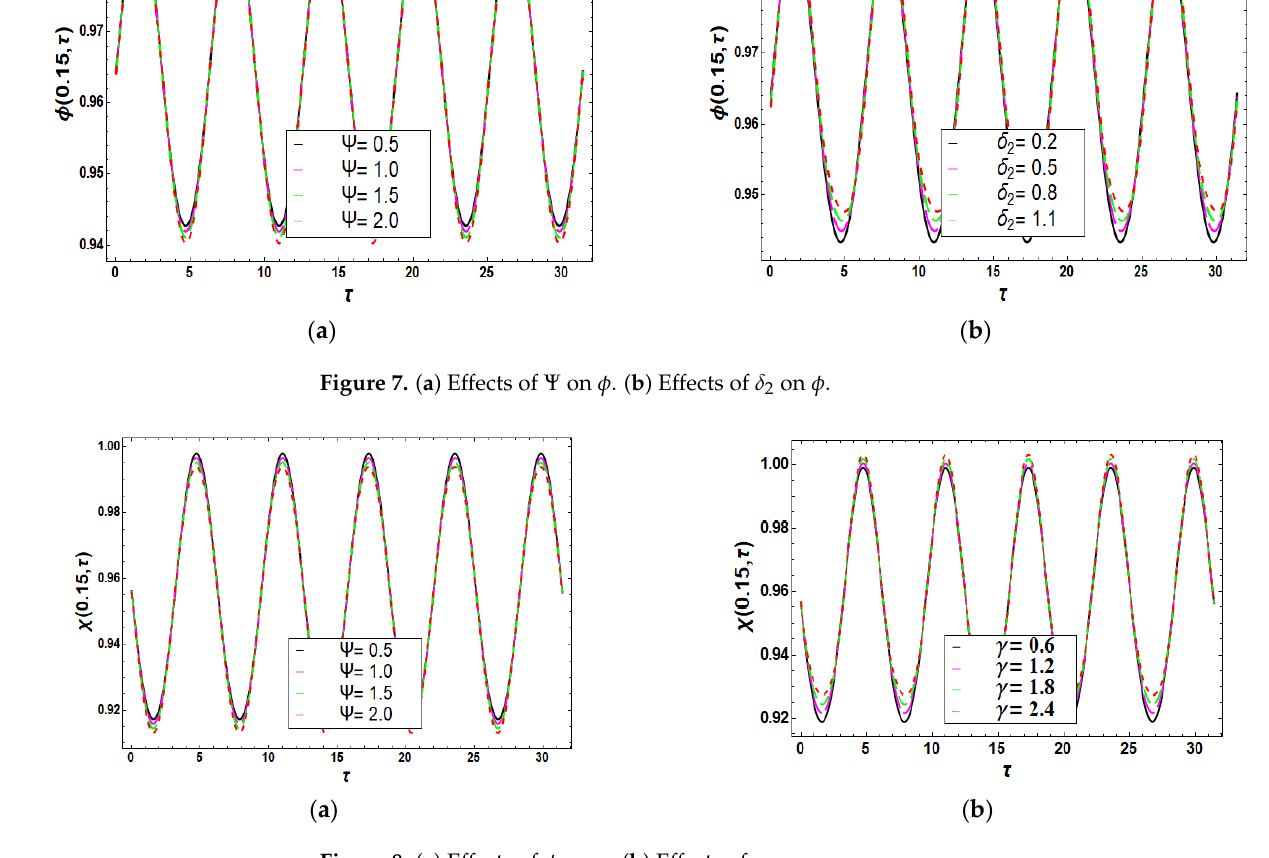
ϖ γ ϖ γ and . and .